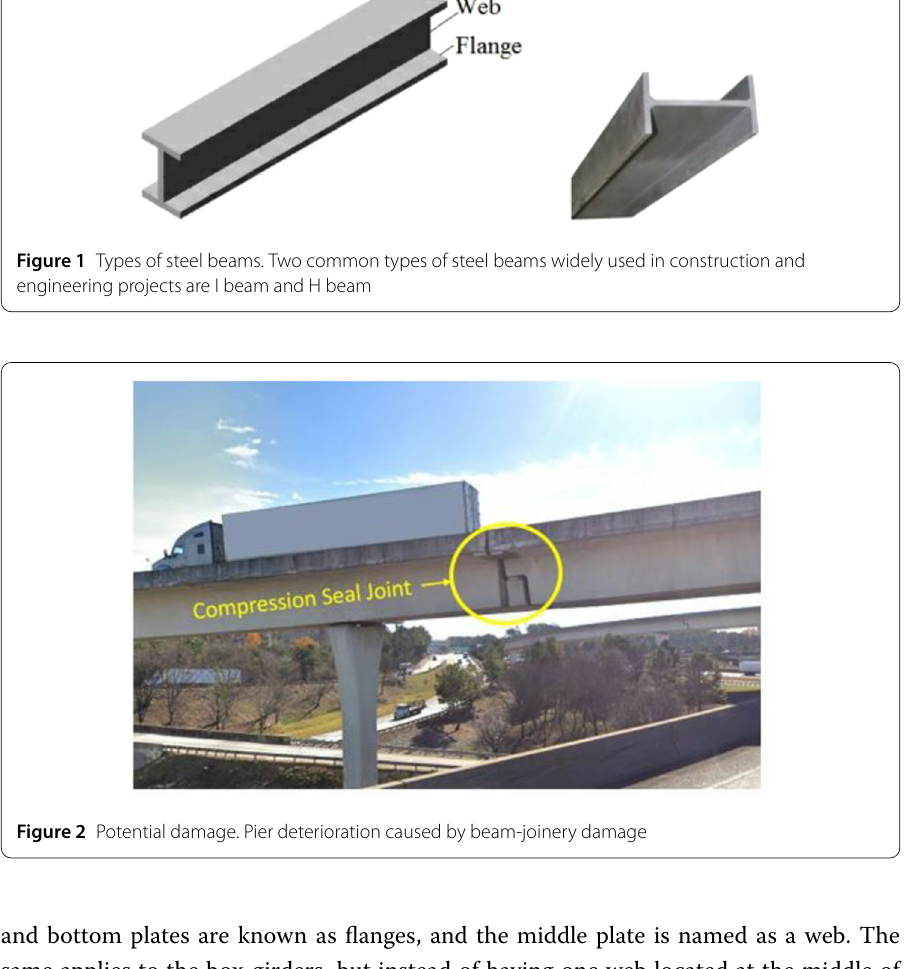
and bottom plates are known as flanges, and the middle plate is named as a web. The same applies to the box-girders, but instead of having one web located at the middle of two flanges, there are multiple webs between two flanges assembling numerous chamber box girders